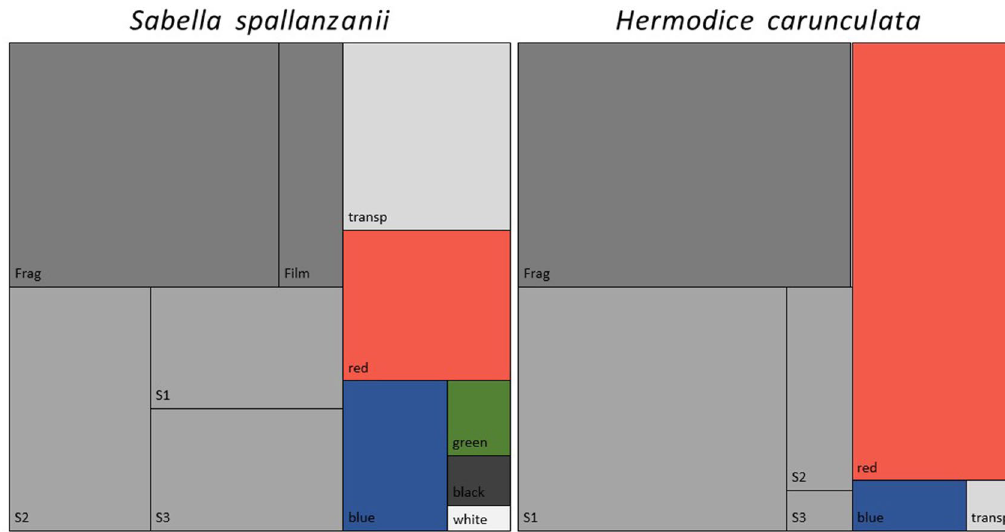
Figure 3. Physical characterization of ingested microplastics by Sabella spallanzanii and Hermodice carunculata. A treemap chart (Excel) with shape categories (Frag: fragments; Film: films), size classes (S1: size class 1, 90 µm–330; S2: size class 2, 330 µm–1 mm; S3: size class 3, 1–5 mm) and colour (transp: transparent; red: red; blue; green: green; black: black; white: white). The image is obtained by the software Excel (ver. 2014, https:// www. micro soft. com/ it- it/ micro soft- 365/ excel) and the software PowerPoint (ver. 2014, https:// www. micro soft. com/ it- it/ micro soft- 365/ power point).